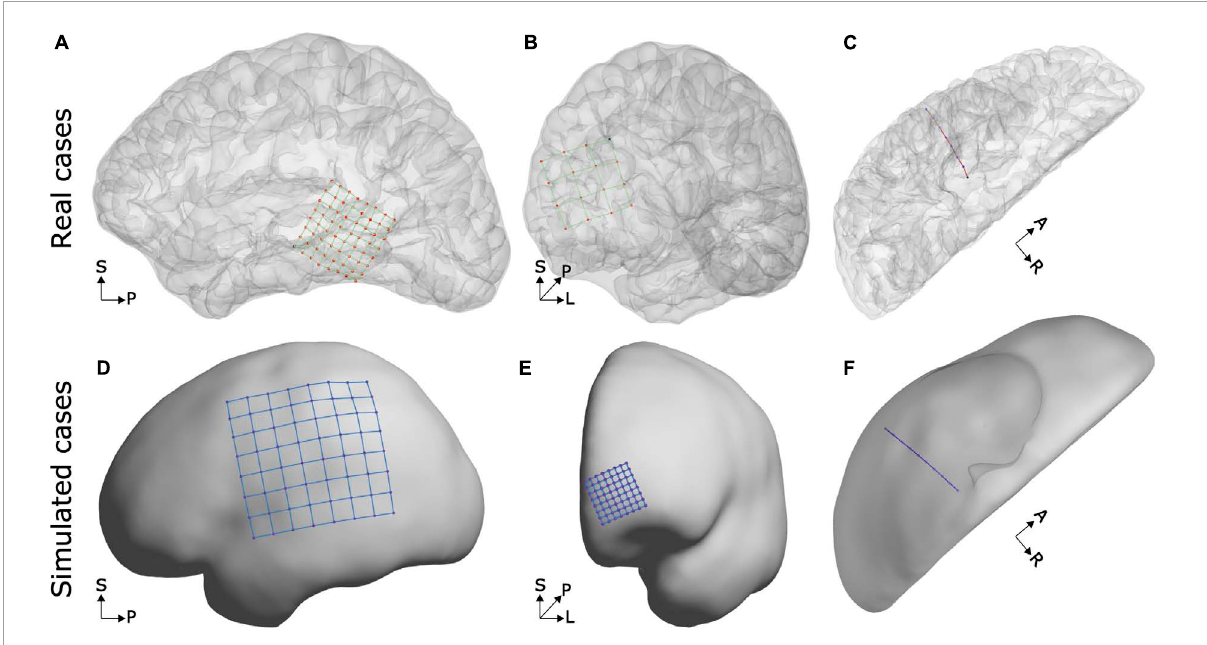
FIGURE4 Examples of real and simulated electrode coordinates. Observe that in real and simulated cases, the grid coordinates follow the brain curvature and that depth electrode trajectories are slightly bent. The top row shows real electrode coordinates from an 8 × 8, 3 mm IED array over the lateral temporal cortex (A) , a 4 × 4, 10 mm IED array over the frontal pole (B) , and an 8 contacts, 5 mm IED, depth electrode array into the temporal lobe (C) . The bottom row shows simulated electrode arrays from an 8 × 8, 10 mm IED grid over the lateral fronto-temporo-parietal cortices (D) , an 8 × 8, 3 mm IED high-density array over the frontal pole (E) , and a 10 contacts depth electrode array into the temporal lobe (F) . SCE and pial surfaces are depicted semi-transparently in the top plots to enhance